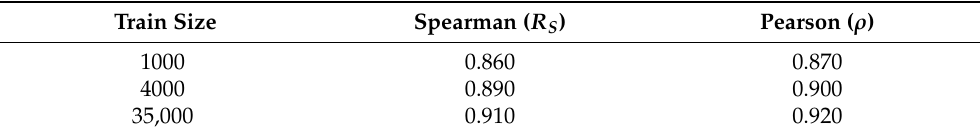
Table 1. Dependence of the quality of approximation on the size of the training set.